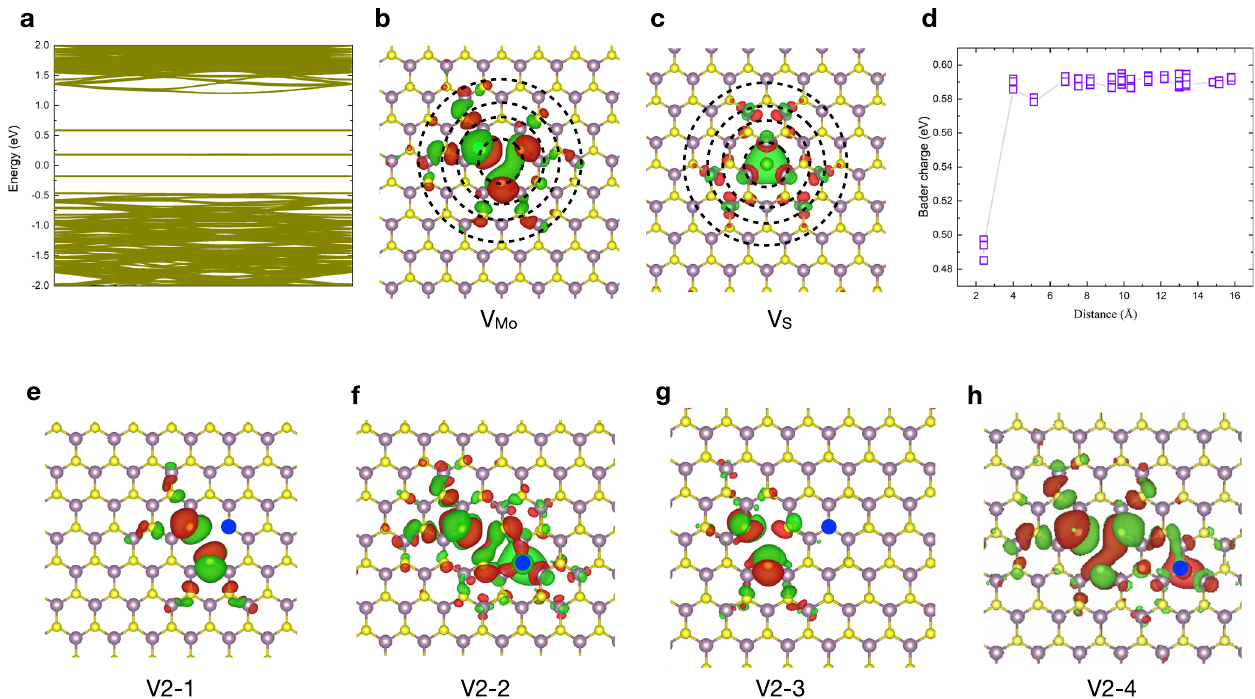
Fig. 4 The orbital coupling of a Mo and an S vacancy in MoS 2 . a The band structures for a Mo vacancy structure. The wave function of HOMO for structures with b a Mo vacancy and c an S vacancy. The dash circles centering at the vacancies are a guide to the lattice sites. d The Bader atomic charge for S atoms around a Mo vacancy in ( b ). The wave functions for defect con fi gurations with an S vacancy occupy the e fi rst, f second, g third, and h fourth nearest site of a Mo vacancy. The blue dots indicate the S